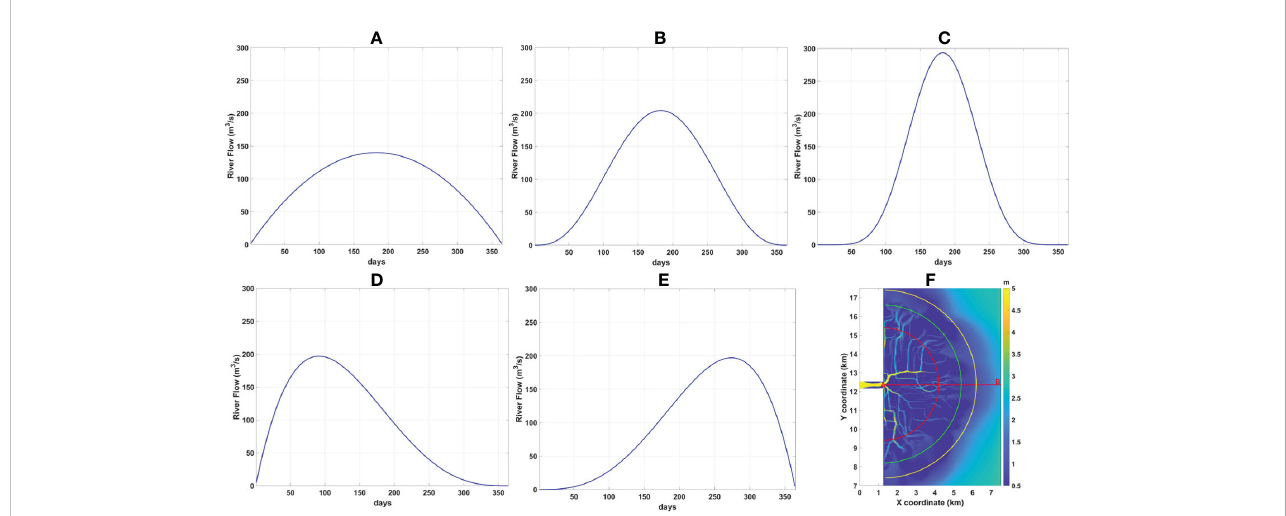
FIGURE 1 The hydrographs implemented in the model: (A) Platykurtic (B) Mesokurtic (C) Leptokurtic (D) Left Skewed and (E) Right Skewed fl ow distribution for one year. (F) The delta bathymetry. The red line AB measures the 6km distance from the river mouth (point A) corresponding to the length of the salt intrusion curve displayed in Figure 2B. The colored semicircles with their centre at point A and radius 3km (red), 4.2km (green) and 5km (yellow) visualize the cross sections over which salinity is averaged for the results analysis in sections 3.1, 3.2 and